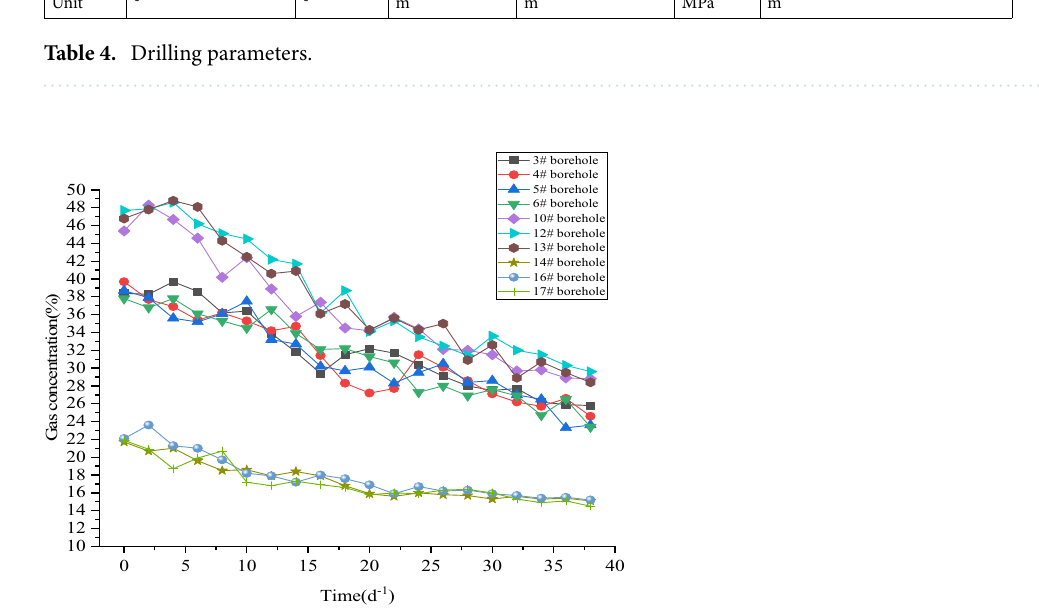
Figure 12. Comparison of the gas concentration in